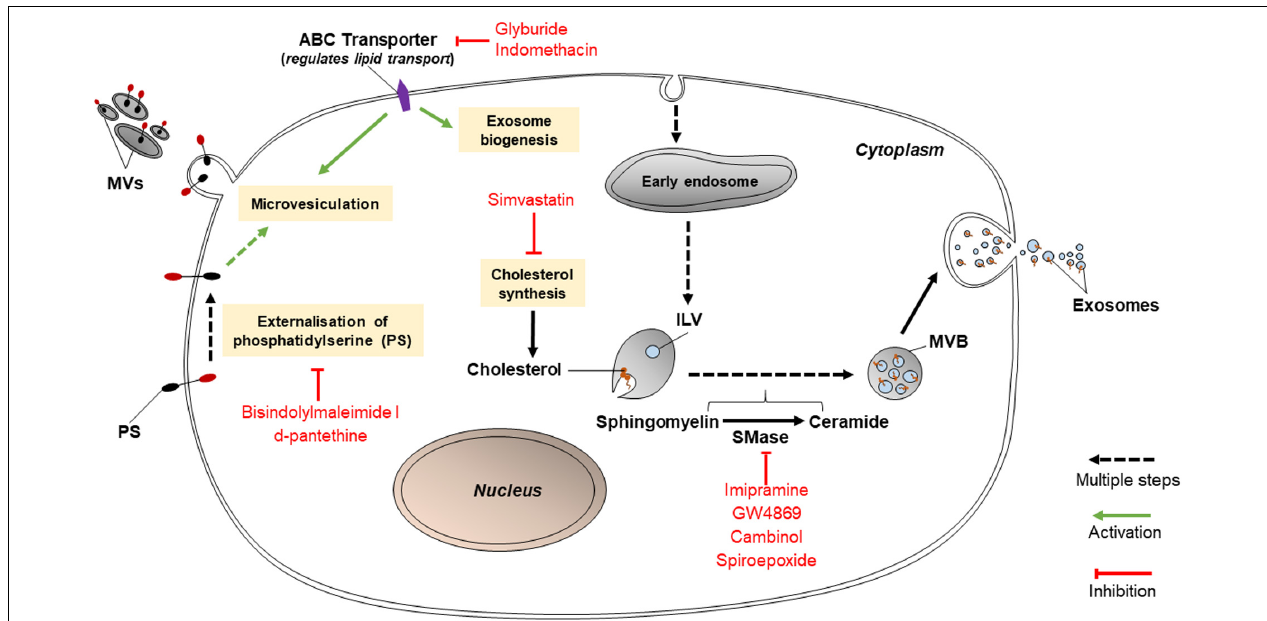
FIGURE 2 | Inhibitors of lipid-related pathways (bisindolylmaleimide-I, d-pantethine, glyburide, indomethacin, simvastatin, imipramine, GW4869, cambinol, and spiroepoxide) inhibit EV